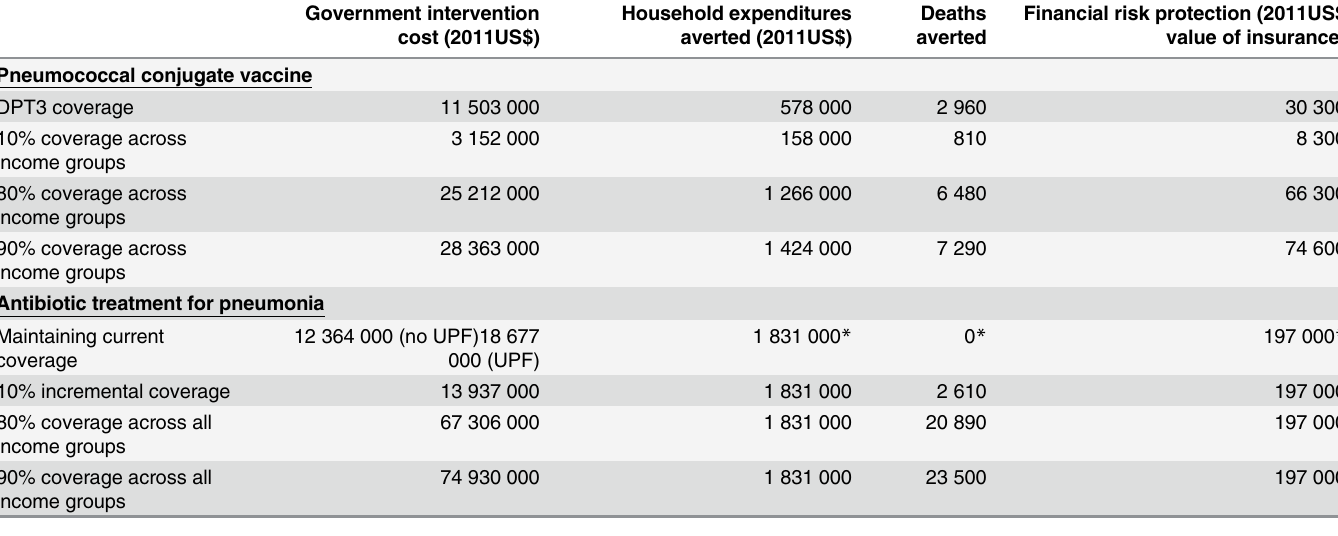
Table 2. Total government intervention costs, household expenditures averted, deaths averted, and financial risk protection, for each of the two policies (pneumonia treatment and pneumococcal vaccines) provided by universal public finance at different coverage levels in Ethiopia. Government intervention Household expenditures cost (2011US$) averted